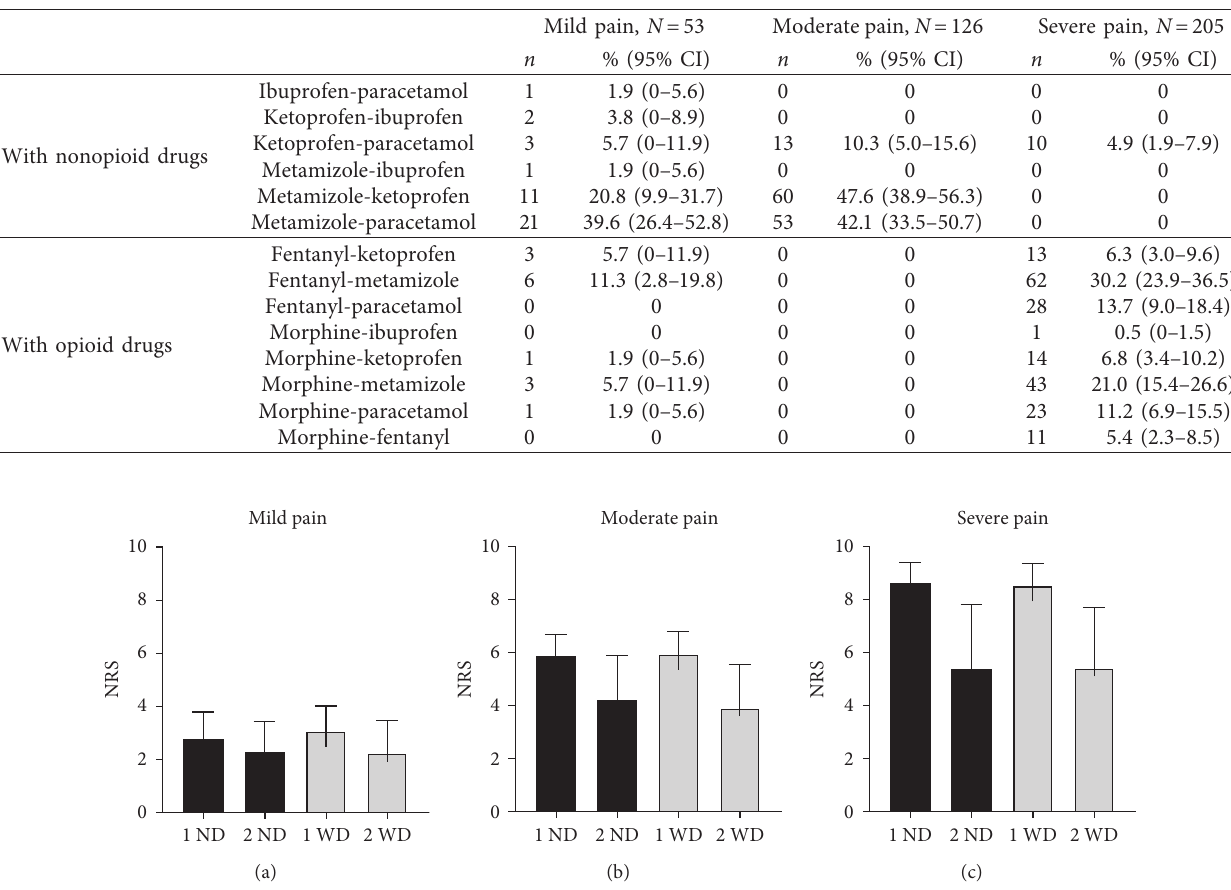
Table 2: Multimodal analgesia in patients with mild, moderate, and severe pain.